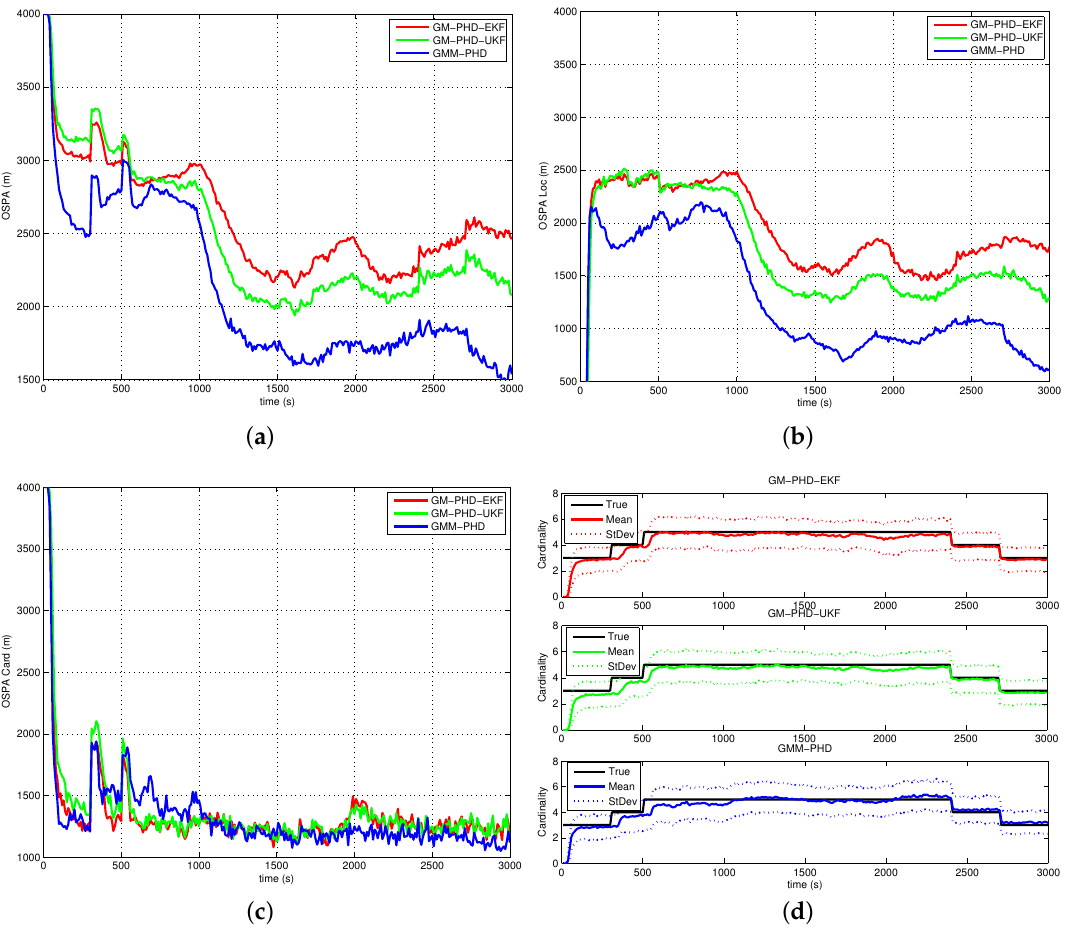
Figure 7. Results of Case 3: ( a ) OSPA distance; ( b ) OSPA localization; ( c ) OSPA cardinality; ( d ) Cardinality statistics.